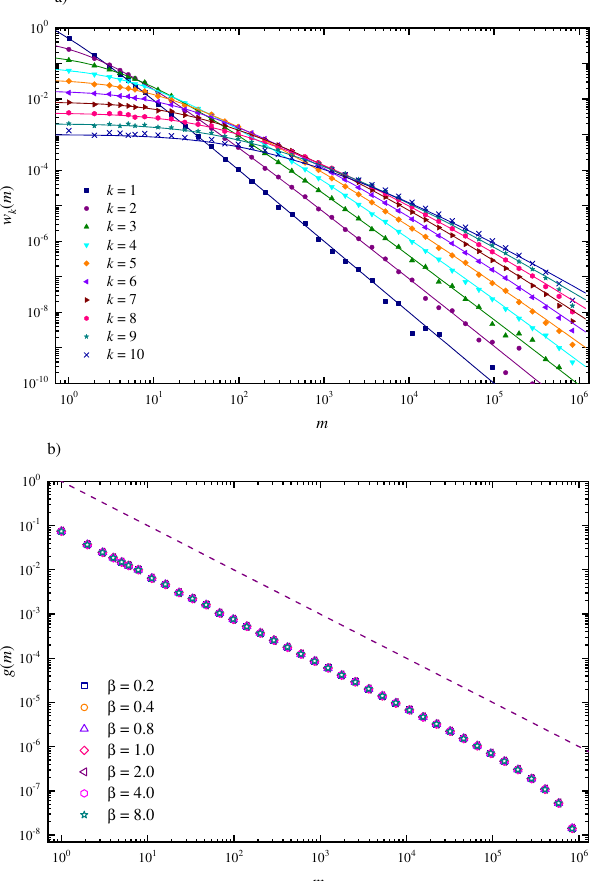
Figure 3. ( a ) The probability density functions, w k ( m ) of records for a given order k which are broken after m time steps. Numerical simulations (symbols) as well as analytical results (solid curves, Equation (13)) are shown for the first several orders of k = 1,2, . . . ,10. ( b ) The distribution of interevent times, g ( m ) , between successive record-breaking events for several values of model parameters are given. For reference, the non-normalized histogram G ( m ) = 1/ m is given as a dashed